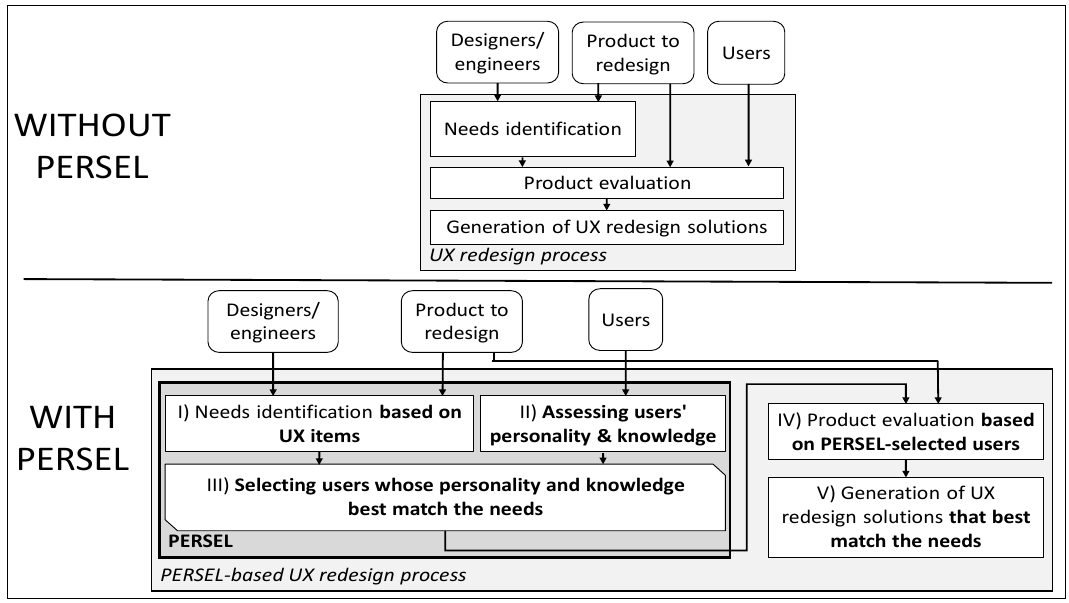
Figure 1. The role of PERSEL (PERsonality-based SELector) in the UX redesign process.